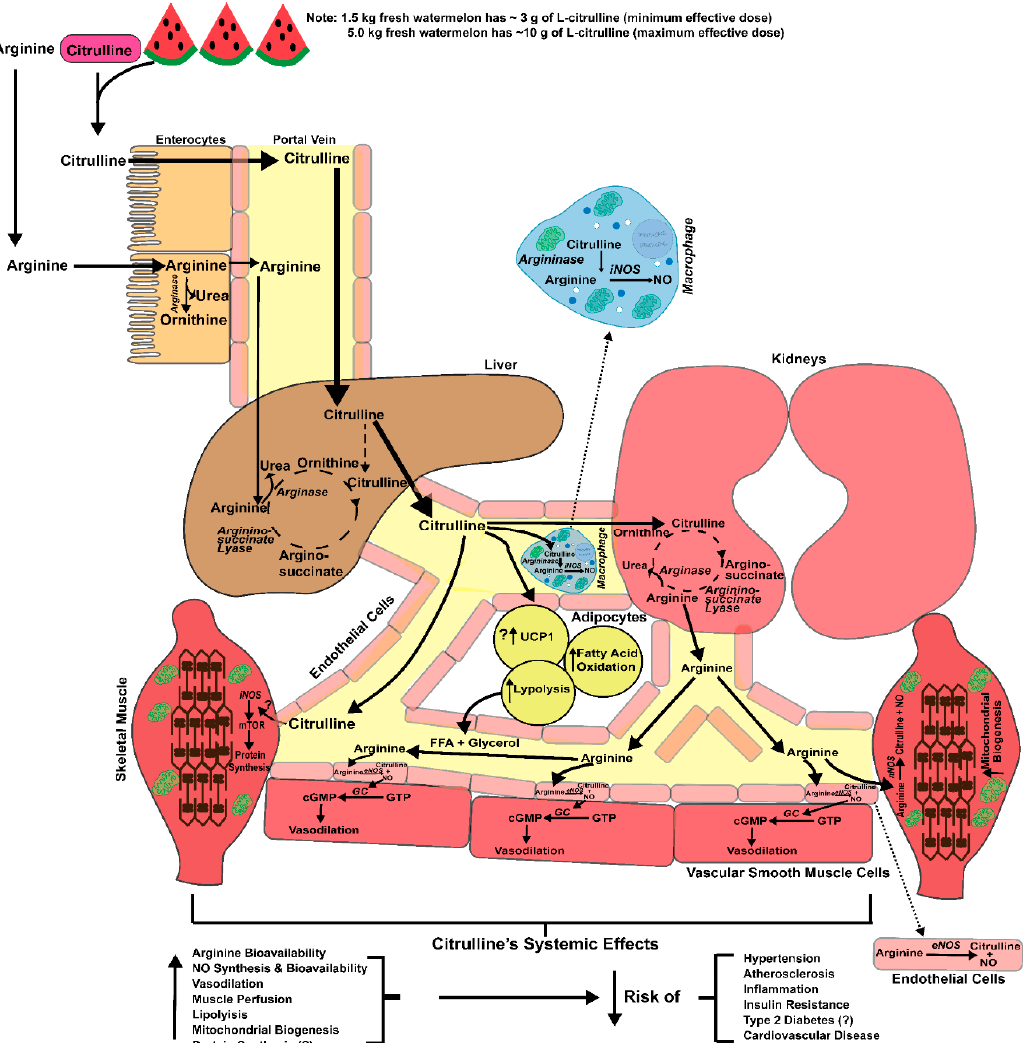
Figure 1. Comparison of oral L -citrulline (via pharmaceutical/nutraceutical grade L -citrulline or watermelon products) versus oral L -arginine. The activity of the arginase enzyme located in the enterocytes of intestines and liver (first-pass extraction) substantially reduces the availability of oral L -arginine, instead yielding increased urea and L -ornithine production. L -citrulline is not acted on by arginase enzyme or first-pass extraction but is converted to L -arginine by argininosuccinate lyase in the kidneys. Increased circulating L -arginine serves a substrate for the eNOS to produce nitric oxide (NO) and increase smooth muscle vasodilation. L -citrulline may directly activate inducible nitric oxide synthase (iNOS) in skeletal muscle and increase protein synthesis via mTOR activation. L -citrulline may indirectly activate neuronal nitric oxide synthase (nNOS) in skeletal muscle leading to increases in NO and stimulation of mitochondrial biogenesis. L -citrulline has reported actions on adipose tissue to increase lipolysis, fatty acid oxidation, and uncoupling protein 1 (UCP1) expression. L -citrulline has also been reported to indirectly activate iNOS in activated macrophages and increase NO production. L -citrulline’s